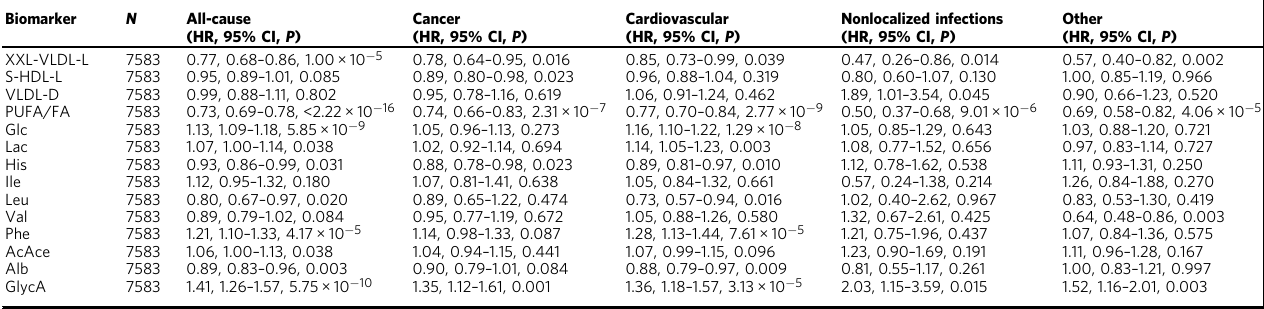
Table 3 Association of the 14 identi fi ed metabolic biomarkers with all-cause and cause-speci fi c mortality in the FINRISK 1997